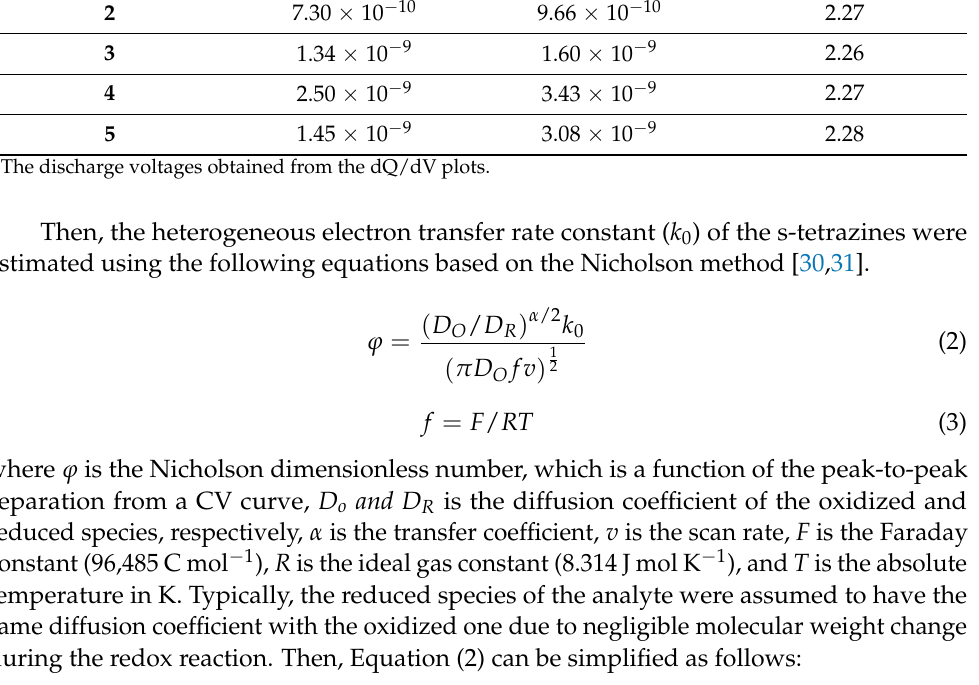
Table 3. Li-ion diffusion coefficients ( D Li ) and the discharge voltages of the s-tetrazine electrodes. D Li (cm 2 s − 1 ) for Cathodic